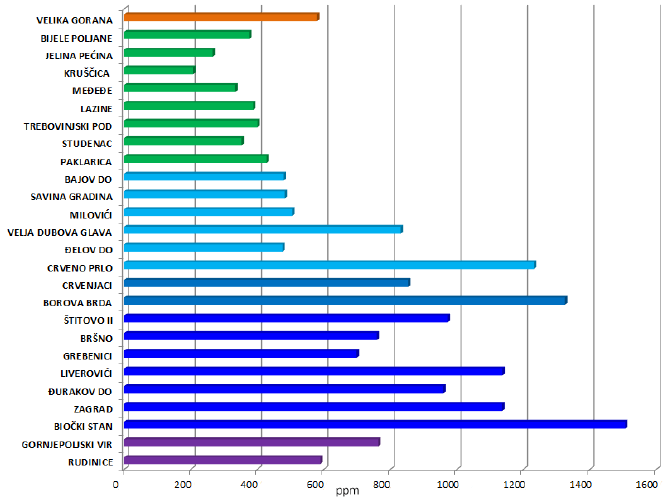
Figure 16. Content of Σ REE + Sc in the studied deposits and occurrences of different bauxite formations in Montenegro, (after REEBAUX [6]), (ppm).